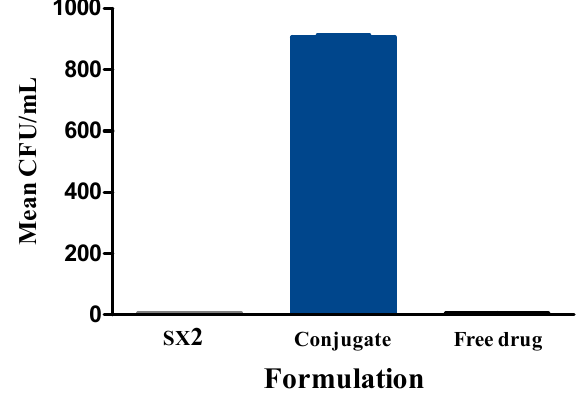
Figure 9. Colony count assay on synovial culture of the infected knee after treatment.